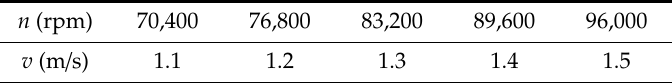
Table 3. Comparison of cutting speed and spindle speed.